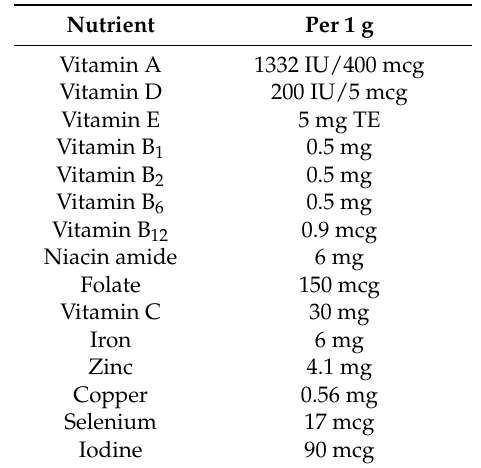
Figure 1. Study profile. * Thirty children died (five from intervention villages before the MNP intervention started and 25 from non-intervention villages throughout the study period). ** End line blood samples were taken from 259 of the 344 children with blood samples collected at baseline: 41 were absent, 1 was a severe-acute-malnutrition case, 2 were transferred and 41 refused to give a blood sample. SNNPR: Southern Nations, Nationalities and Peoples’ Region; CF: complementary food; MNP: multiple micronutrient powder. Table 1. Minerals and vitamins contents of MixMe per serving (1 g